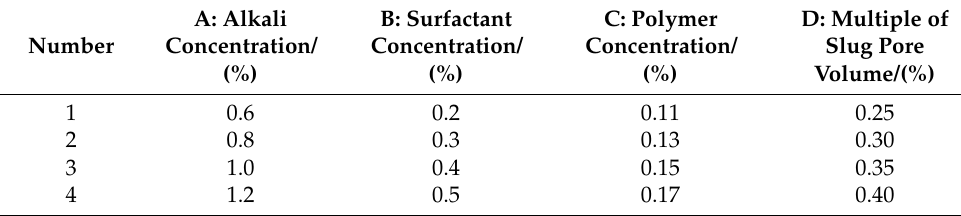
Table 4. Chemical concentration and slug optimization parameter